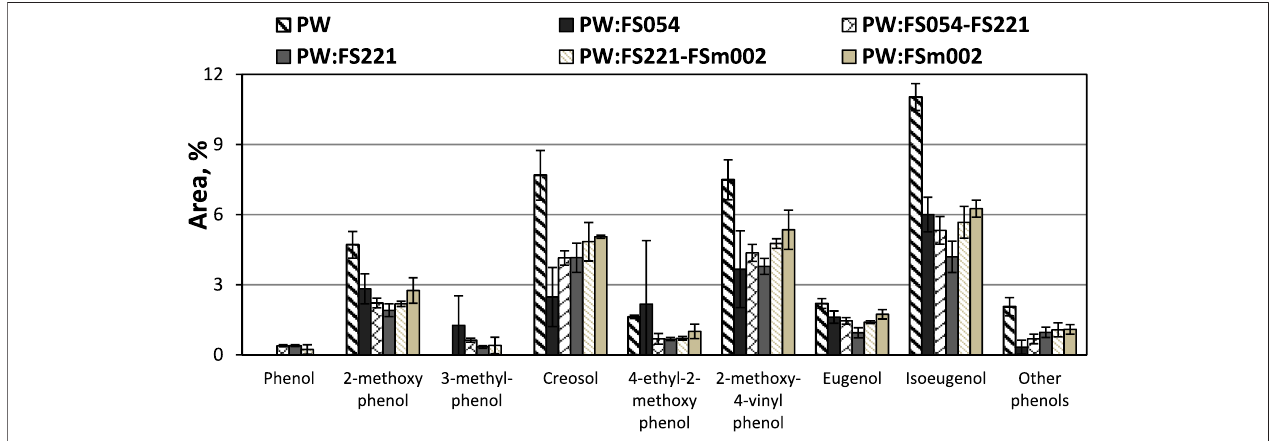
FIGURE 8 | Effect of mono- and dual-sized α -Fe 2 O 3 catalyst particle mixtures on the PW CFP phenols distribution.